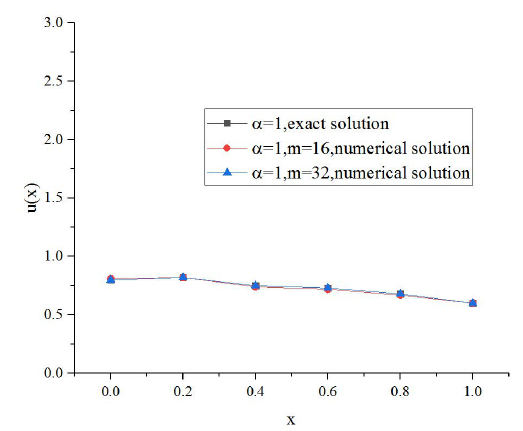
Fig. 1 Comparison between numerical solutions and exact solutions of the integral equation for m at two different values when m = 1.